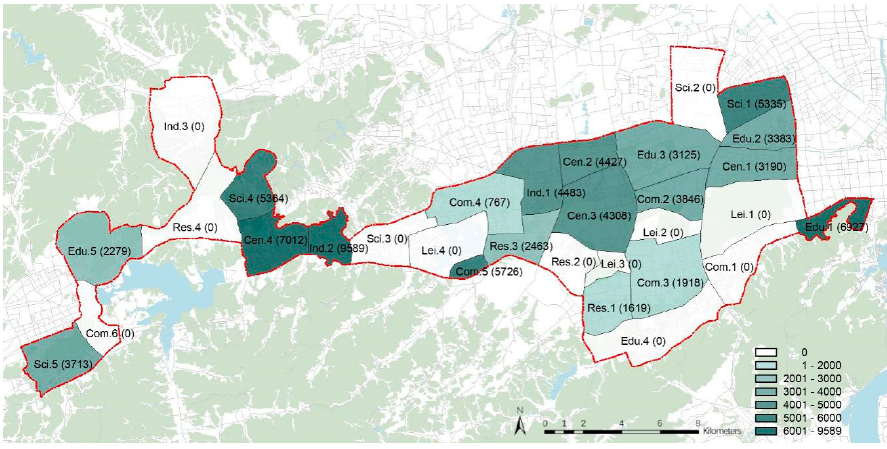
Figure 8. Average commuting distance of each area in the Corridor (units are in meters).